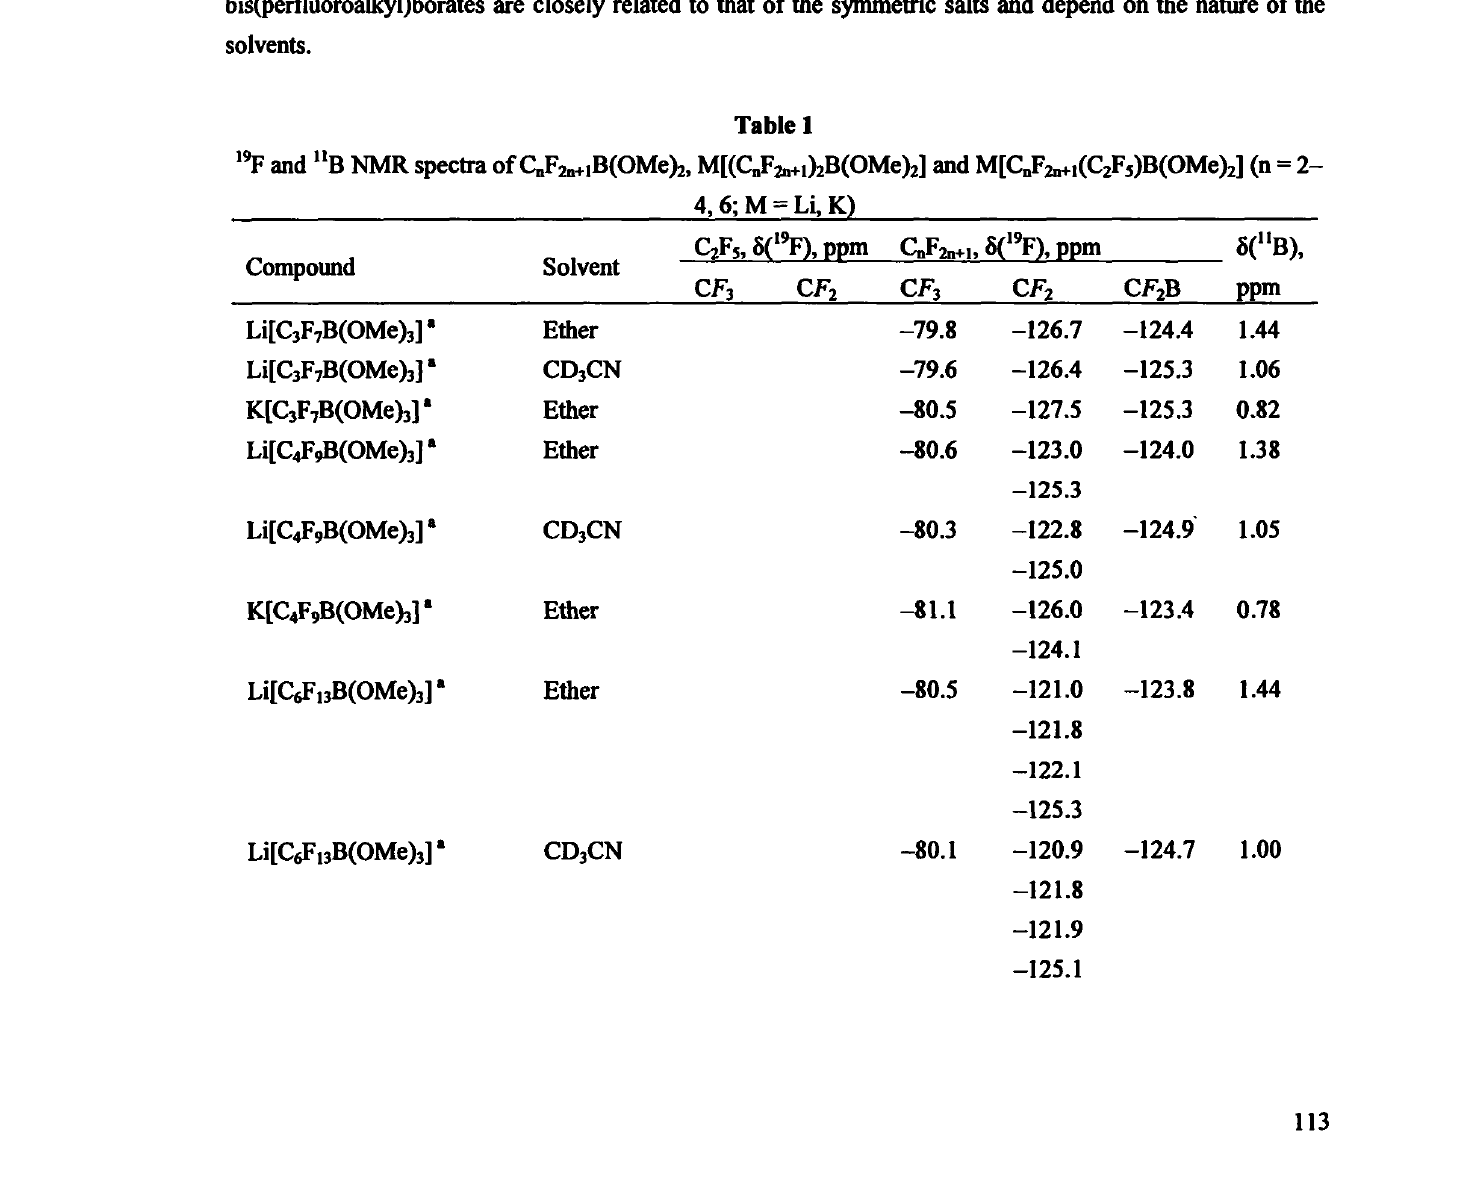
19 F and U B NMR spectra of